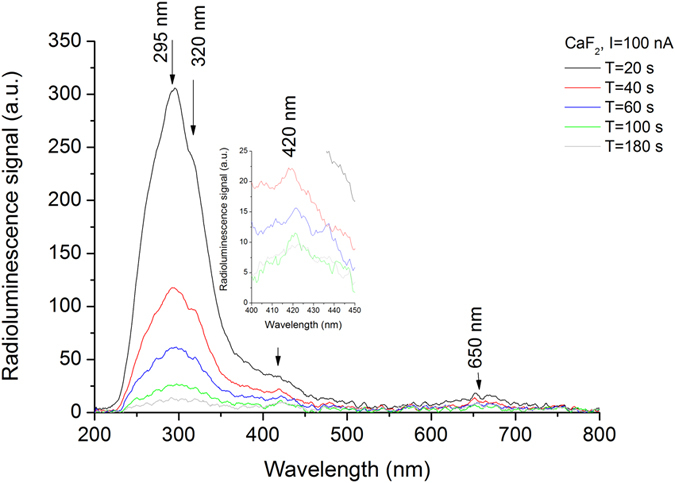
Radioluminescence detected spectrum under alpha particle irradiation of CaF2.